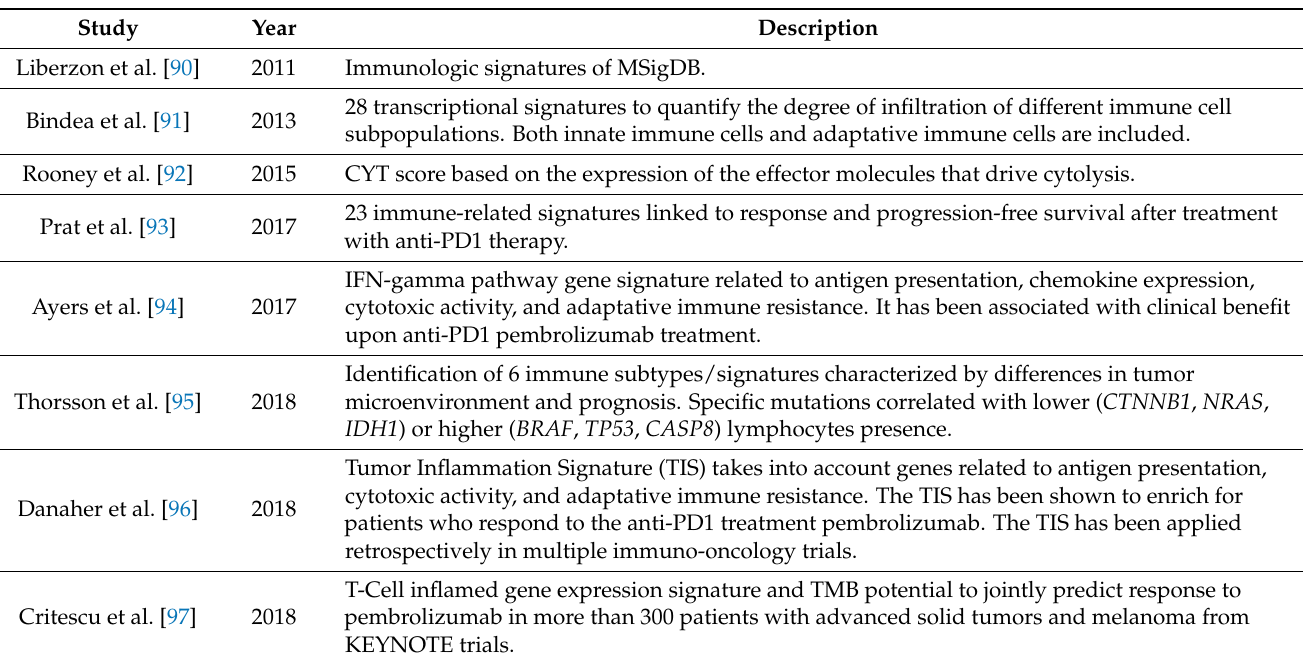
Table 4. Most relevant gene expression signatures associated with immune response